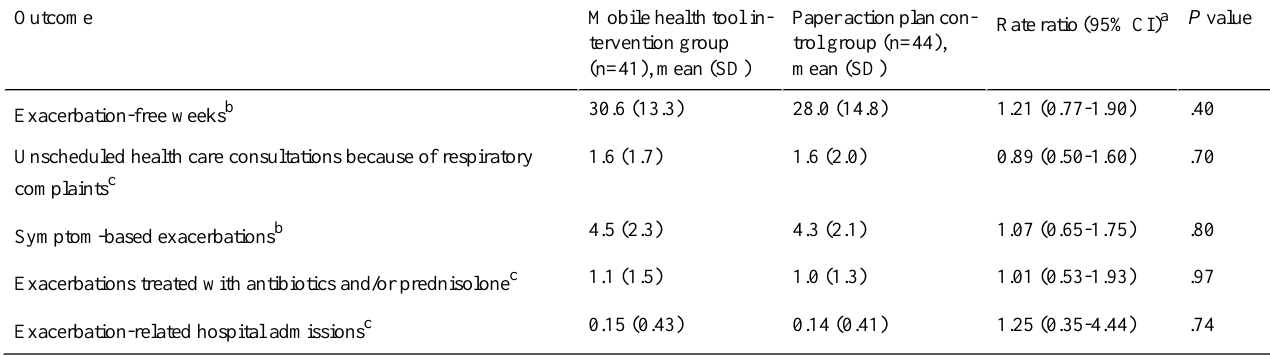
Table 2. Comparison of exacerbation-related outcomes between intervention group and control group